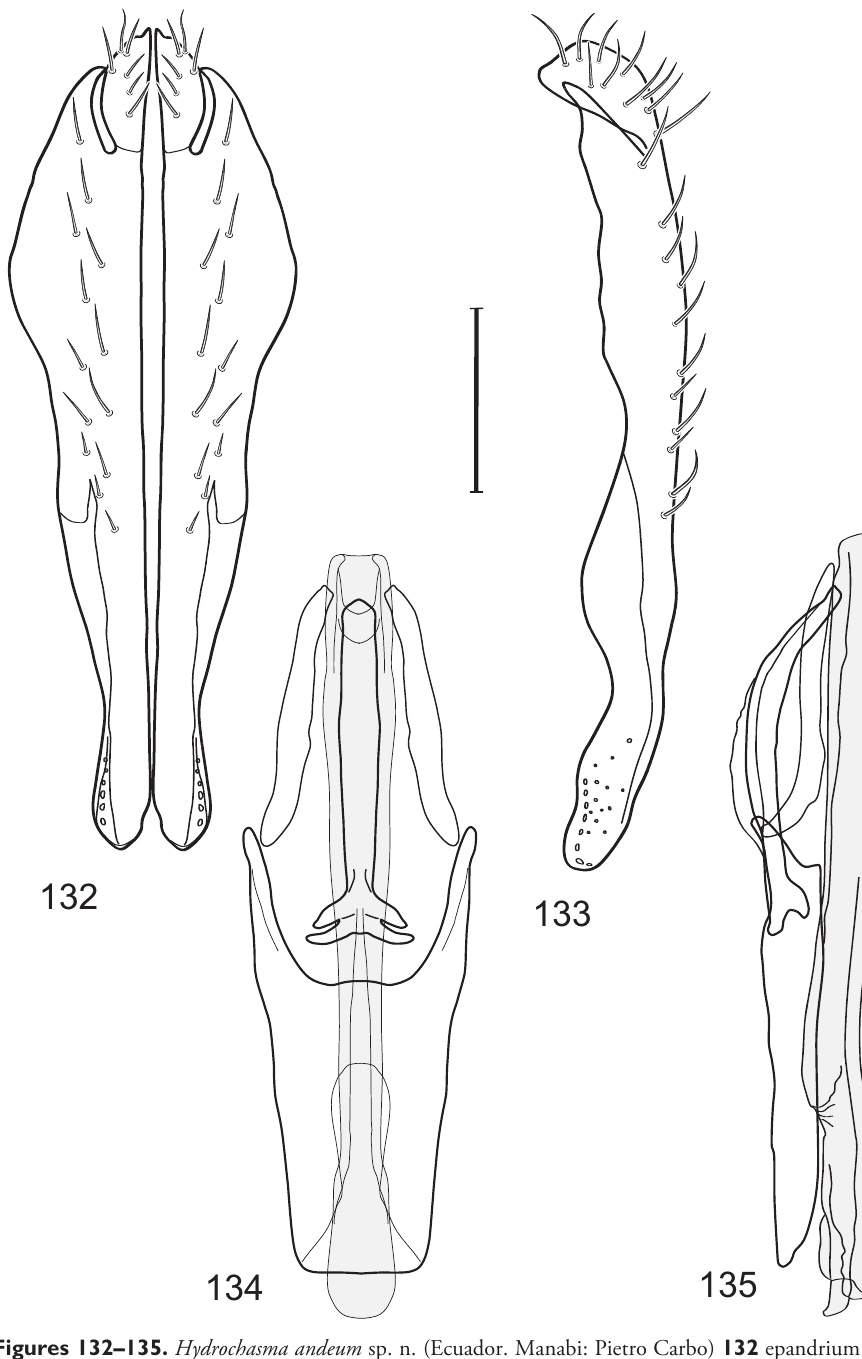
Figures 132–135. Hydrochasma andeum sp. n. (Ecuador. Manabi: Pietro Carbo) 132 epandrium and cerci, posterior view 133 same, lateral view 134 internal structures of male terminalia (aedeagus [shaded], phallapodeme, gonite, hypandrium), ventral view 135 same, lateral view. Scale bar = 0.1